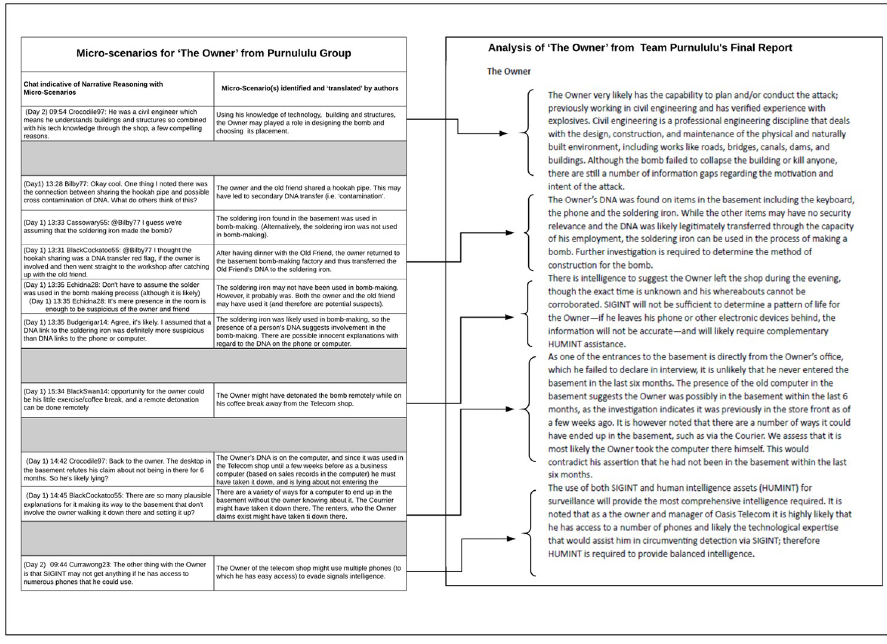
Fig 3. Micro-narratives and their relation to the final